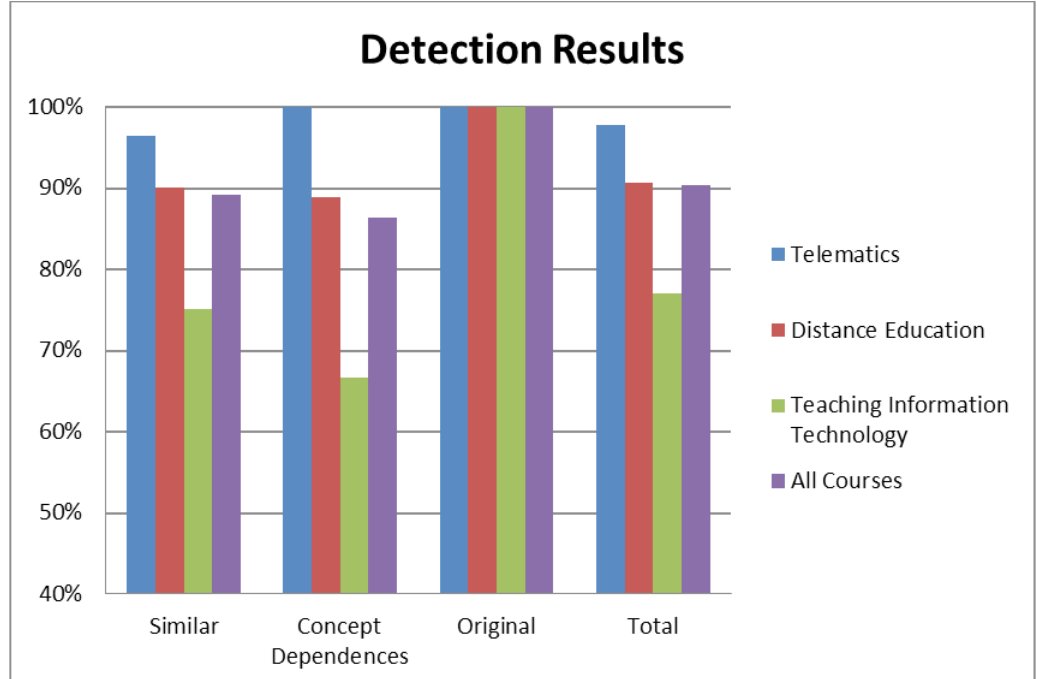
Figure 4 . Detection